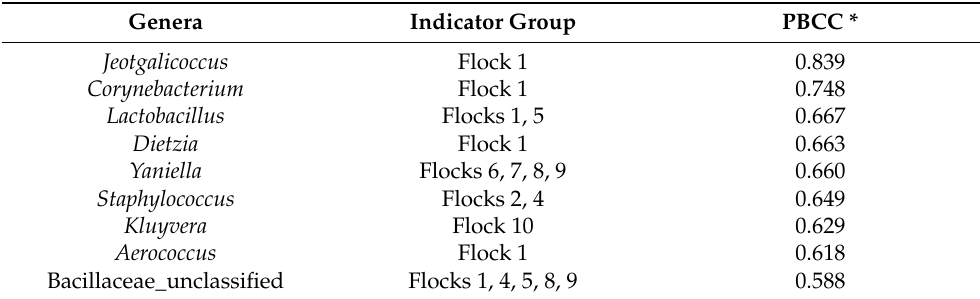
Table 2. Indicator species for In-House Beetles sampled during flock rotations. Only those genera whose relative abundances across all flocks were 0.05% or higher and had a p -value of ≤ 0.001 and Point Biserial Correlation Coefficient (PBCC) * value ≥ 0.50 are shown. n = 8 composite samples/Flock. Genera Indicator Group PBCC * Jeotgalicoccus Flock 1 0.839 Corynebacterium Flock 1 0.748 Lactobacillus Flocks 1, 5 0.667 Dietzia Flock 1 0.663 Yaniella Flocks 6, 7, 8, 9 0.660 Staphylococcus Flocks 2, 4 0.649